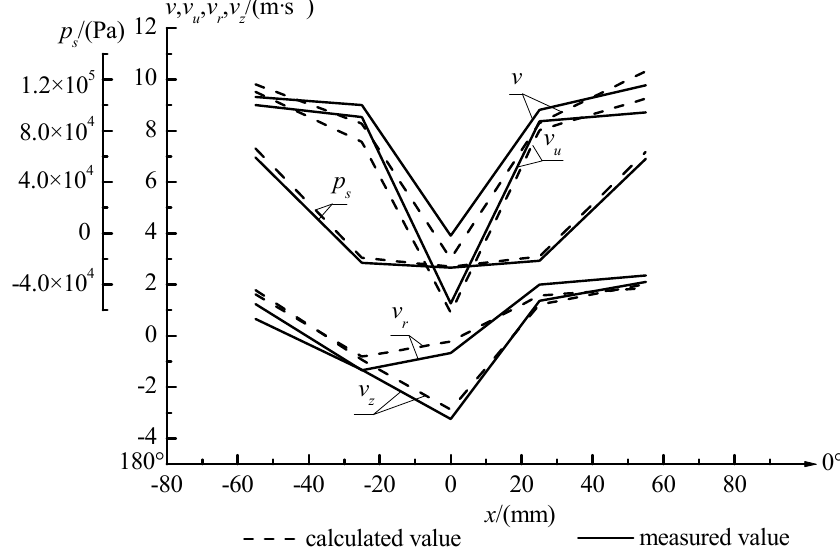
Figure 13. Calculated and measured curves of flow field curves on the axial-cross-section Z = 12.5 mm.